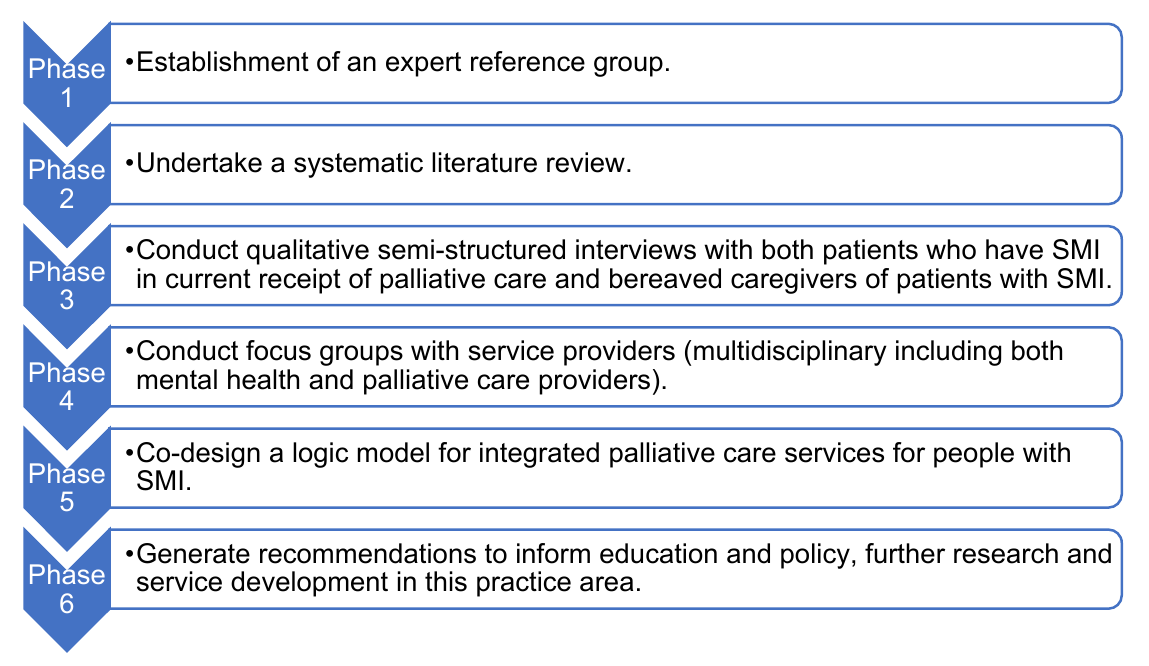
Figure 1. Overview of the six stages of the study.